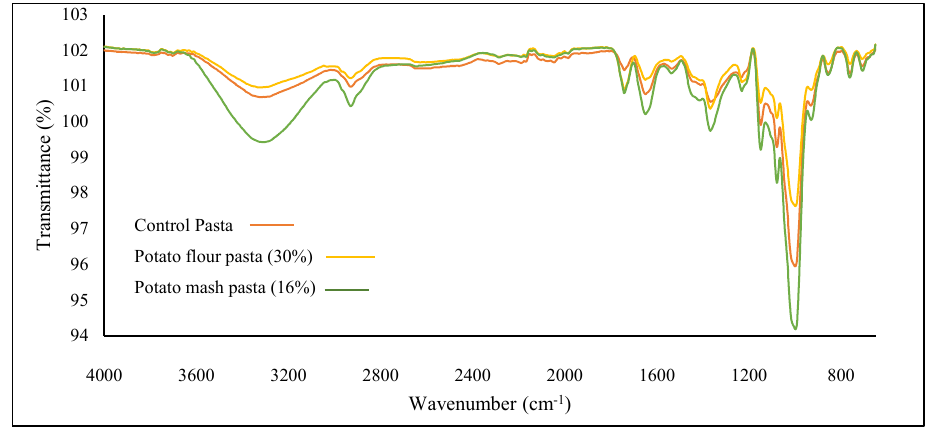
Figure 1. FTIR spectra of control pasta, potato flour pasta, and potato mash pasta.